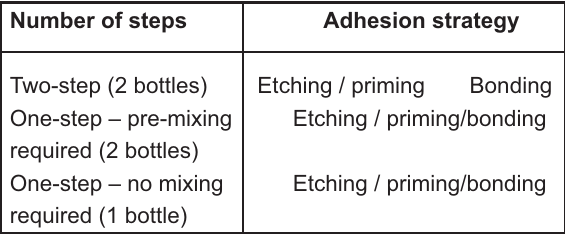
Figure 9 - Self-etching systems – adhesion